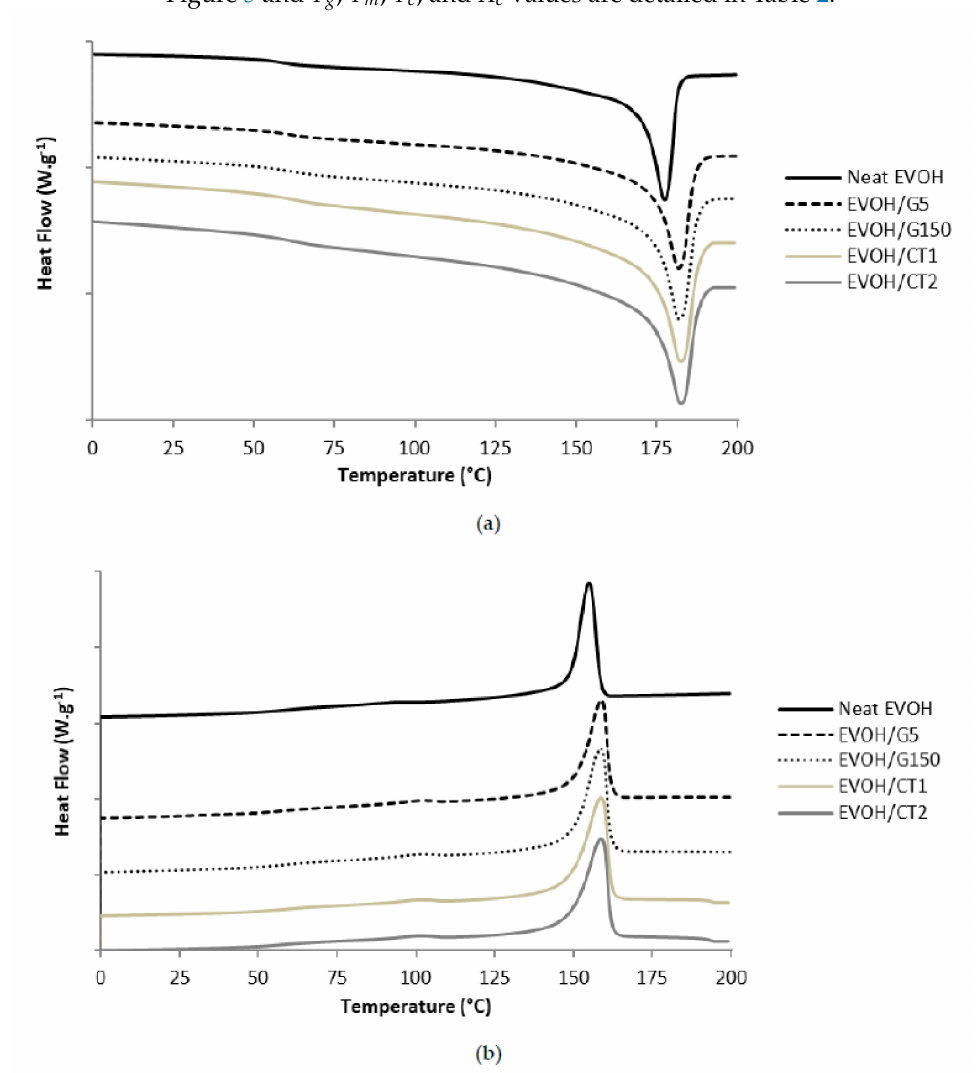
Figure 5. DSC ( a ) heating and ( b ) cooling thermograms of neat EVOH and studied nanocomposites (scanning rate = 10 ◦ C · min − 1 , a w = 0, shifted curves). Table 2. Comparison of the glass transition temperature ( T g ), melting temperature (T m ),